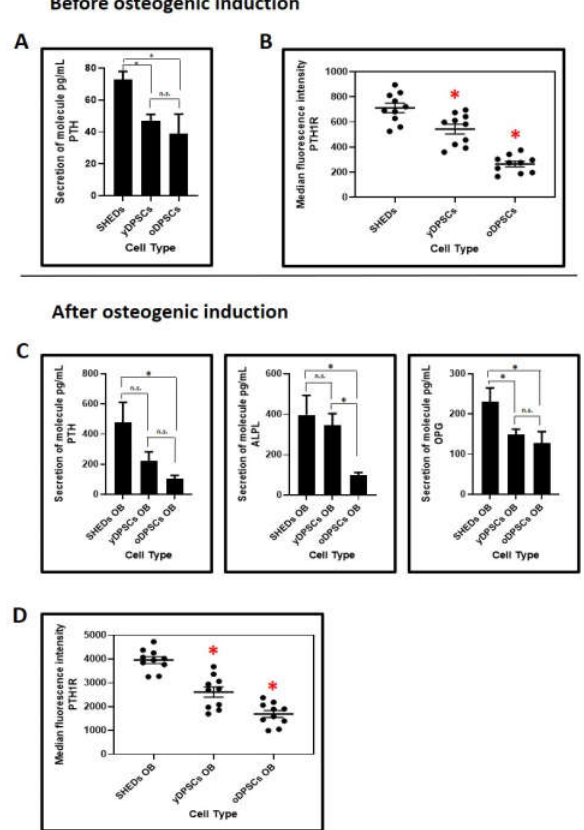
Figure 4. ELISA-based protein expression analyses and flow cytometry-based surface protein analysis. ( A,B ) Comparative protein expression levels of PTH and PTH1R were assessed in SHEDs, yDPSCs, and oDPSCs. ( C,D ) On the 14th day of osteogenic induction, comparative protein expression levels of PTH, PTH1R, ALPL, and OPG were assessed in SHEDs, yDPSCs, and oDPSCs ( n = 5). n.s.: not significant, * p < 0.05. SHEDs: Stem cells from exfoliated deciduous tooth, yDPSCs: Dental pulp stem cells from young subjects, oDPSCs: Dental pulp stem cells from old subjects, OB: osteoblasts.